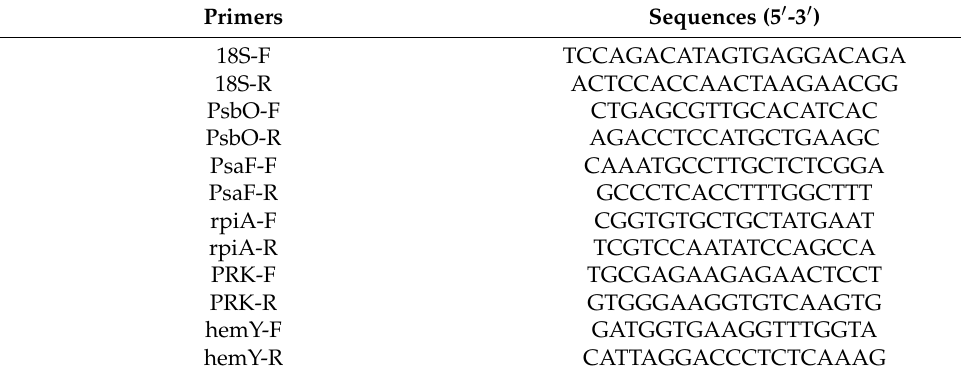
Table 6. The primer sequences of